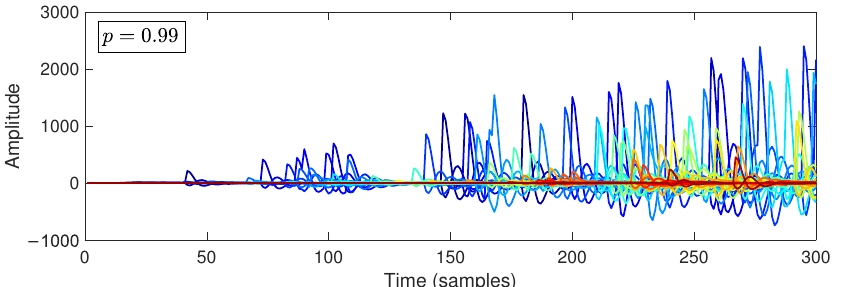
Figure 5. Tracking error ζ i ( k ) , with ˜ y i − 1 ( k ) as input and a transmission probability of p = 0.99. In this case, replacing the lost data with zeroes results in string-unstable behavior.